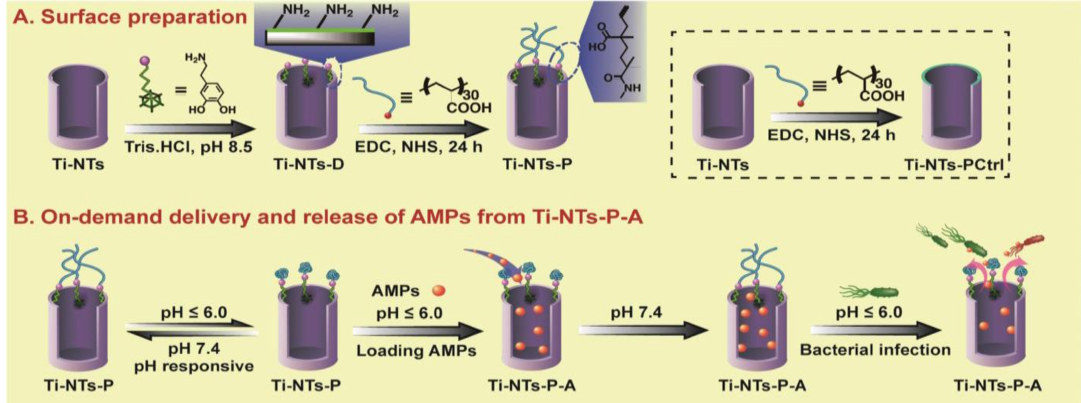
Figure 2. AMPs smart delivery by TiO 2 nanotube system. ( A ) Surface preparation. ( B ) On-demand AMPs’ delivery from the system. Titanium nanotubes (Ti-NTs), titanium nanotubes modified with dopamine (Ti-NTs-D), PMAA “gates” engineered Ti-NTs (Ti-NTs-P), PMAA “gates” engineered Ti-NTs with encapsulation of the loaded AMPs (Ti-NTs-P-A), and control groups (Ti-NTs-PCtrl). Adapted with permission from reference